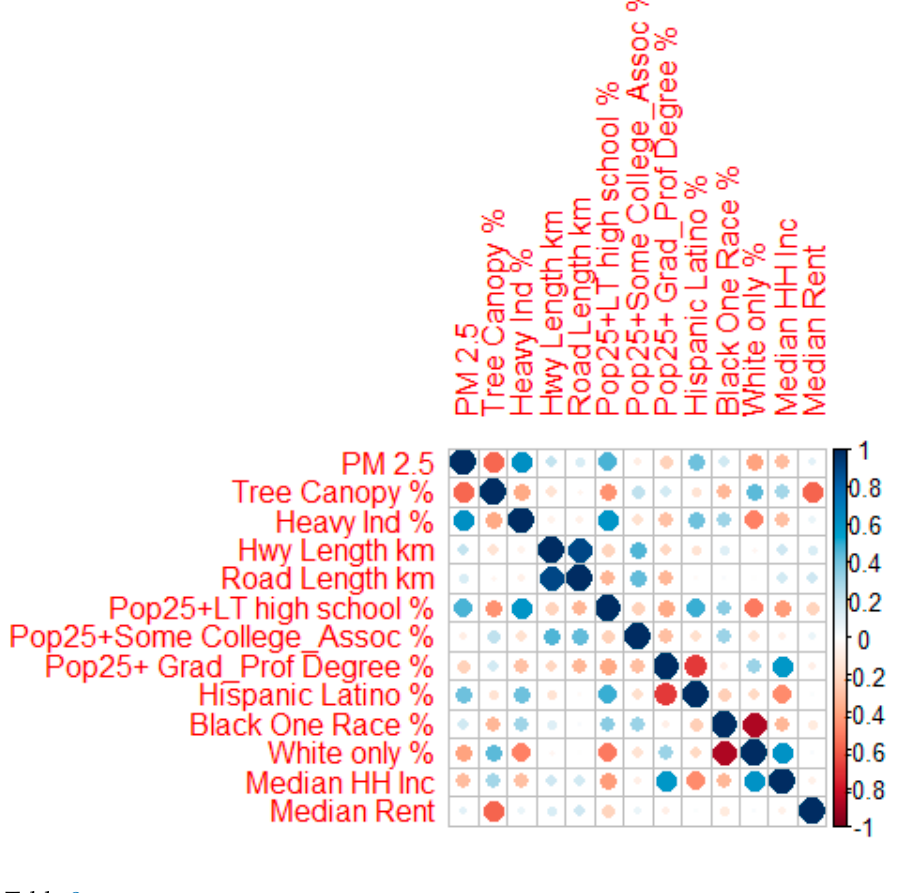
Code for Regression: Code for